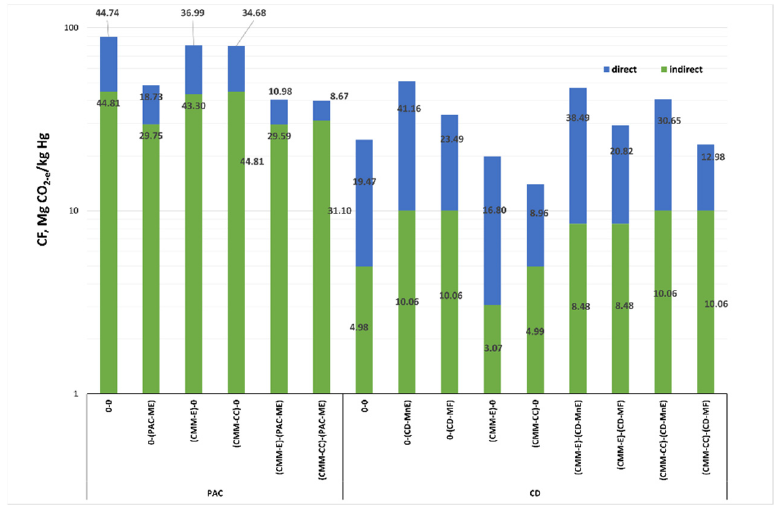
Figure 5. Possible scenarios (combinations) of the mercury removal process, over an assumed life cycle, resulting from sensitivity analysis variables.